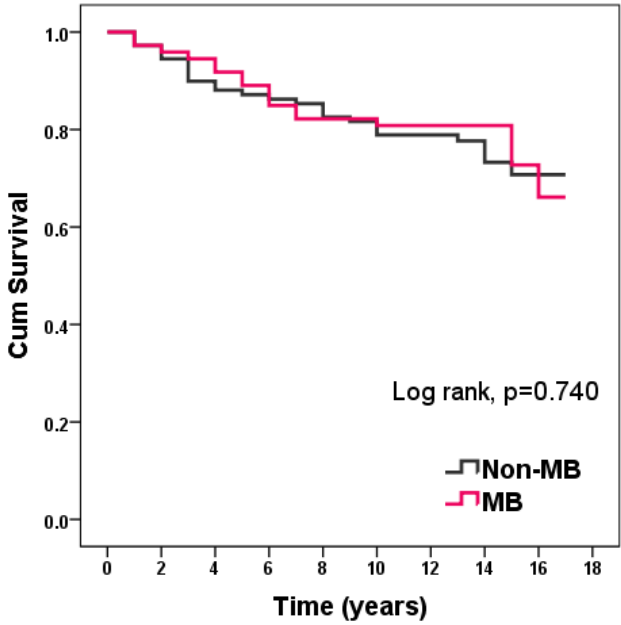
Figure 3. Kaplan–Meier curve of survival in patients with and without MB. Through univariate Cox regression analysis, MB proved not to predict all-cause mortality. The 10-year all- cause mortality was associated only with age (HR 1.060, 95% CI = 1.026–1.094, p < 0.001) and GAL (HR 1.003,